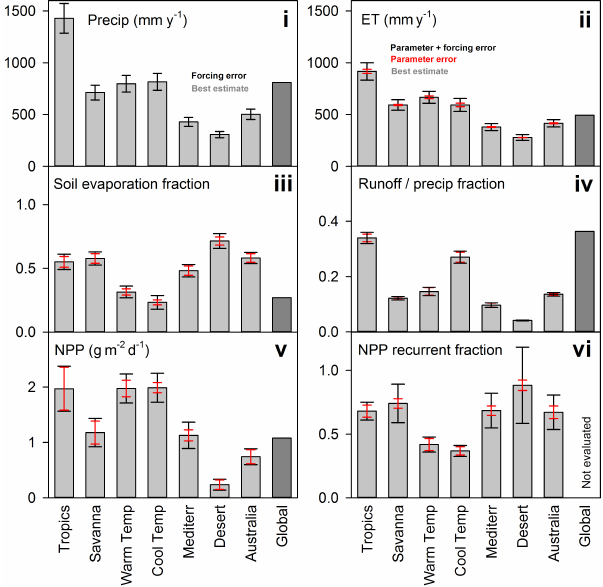
Fig. 11. Long-term mean estimates of key carbon/water cycle vari- ables by bioclimatic region: (i) precipitation; (ii) ET; (iii) soil evap- oration as fraction of ET; (iv) runoff as fraction of precipitation; (v) NPP; and (vi) fraction of NPP attributable to recurrent (mainly grassy) vegetation (global estimate unavailable). Error bars repre- sent 1 σ uncertainties due to parameter (red) and forcing and param- eter (black) uncertainties, combined in